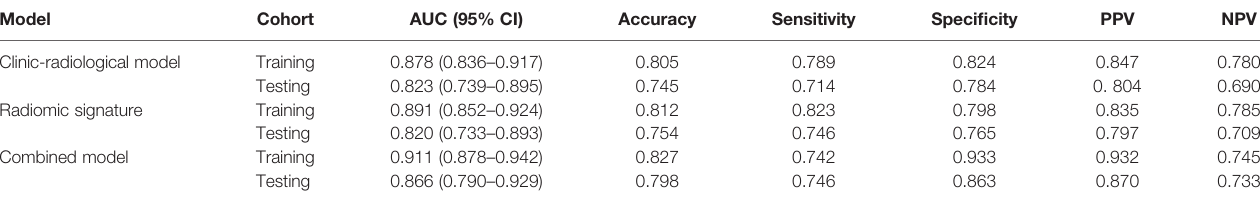
TABLE 3 | The performance of all models in predict glioma-associated epilepsy in training and testing